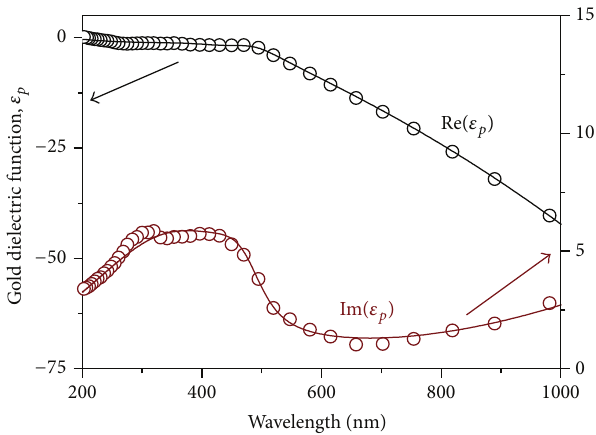
Figure 1: Complex gold dielectric (real and imaginary parts) as function of the light wavelength where the solid lines correspond to the DCP model and the symbols ( I ) represent the experimental data